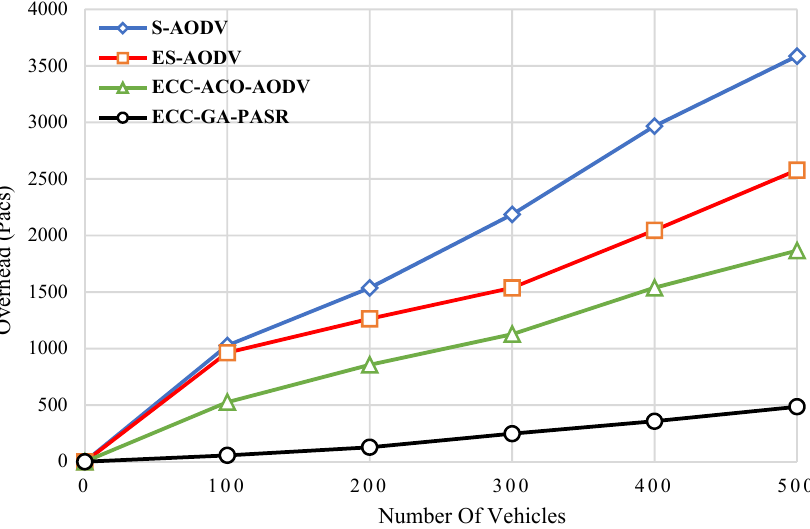
Figure 11. Overhead Calculation based on number of vehicles.